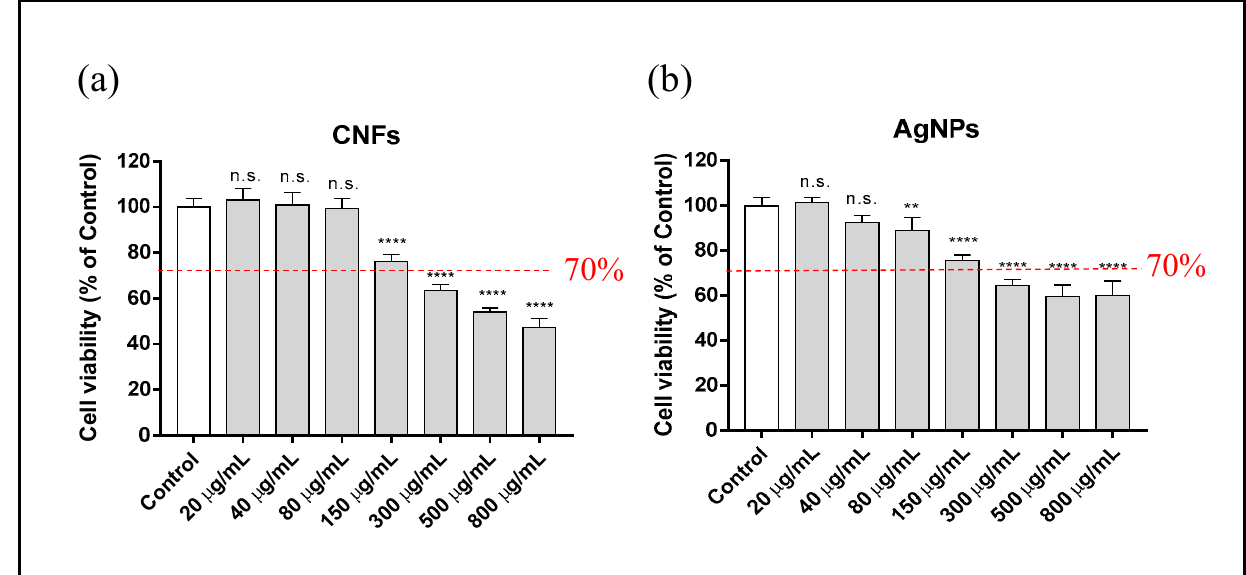
Figure 5. Cytotoxicity assay in human keratinocyte (HaCaT) cells after 12 h exposure to AgNPs ( a ) or CNFs ( b ) at different concentrations ranging from 0 (control) to 800 µg/mL. Cytotoxicity was evaluated by the MTT assay. Results are represented as a % of the control group. Data are shown as the mean ± standard deviation of six replicates. The ANOVA results of the different AgNP or CNF concentrations with respect to control are indicated in the plot. ** p < 0.01; **** p < 0.0001; n.s: not significant. The cell viability limit (70%) for the compounds to be considered non-cytotoxic is indicated.